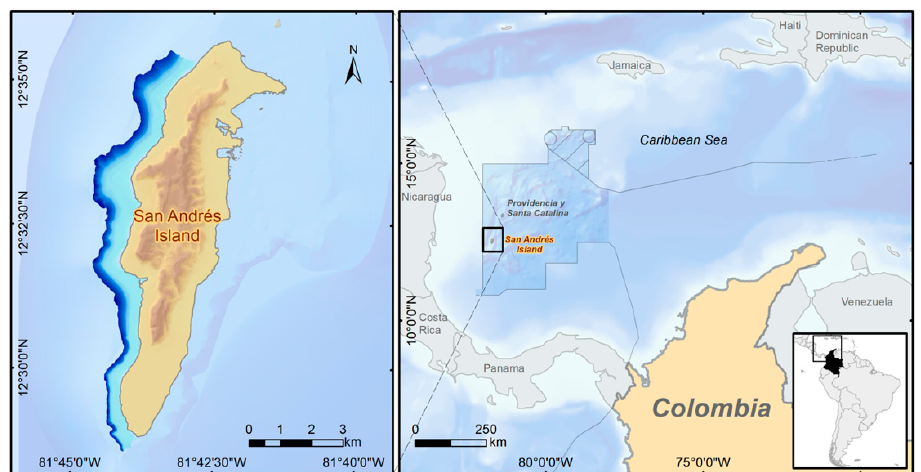
Figure 1. Location of San Andrés Island in the Caribbean Sea. The blue gradient is a bathymetric representation of the sampled area along the leeward side of the island.